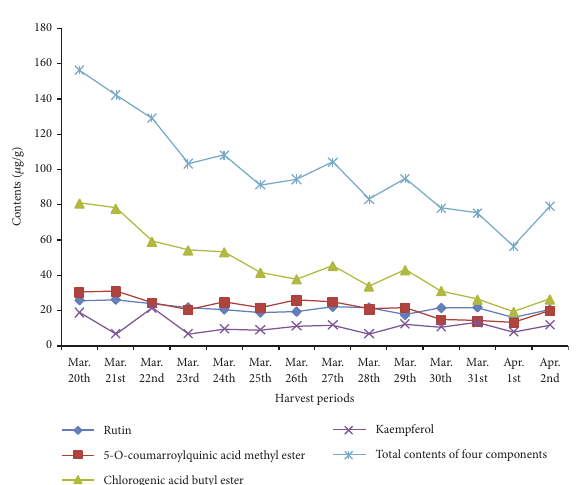
Figure 2: Dynamic change of the contents of four active ingre- dients in A. persica flowers during different harvesting